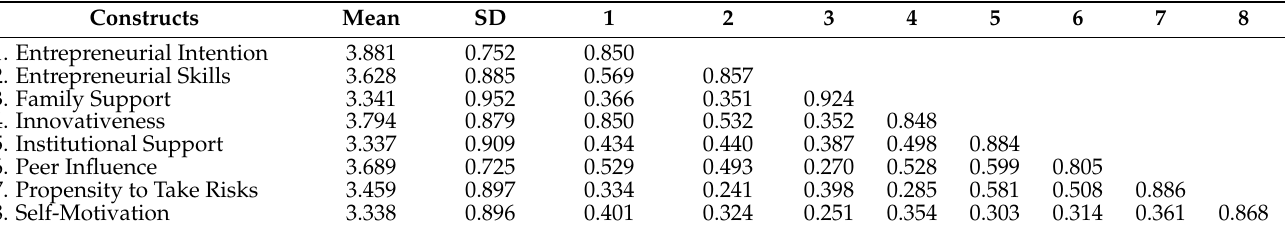
Table 3. Discriminant validity (Fornell–Larcker